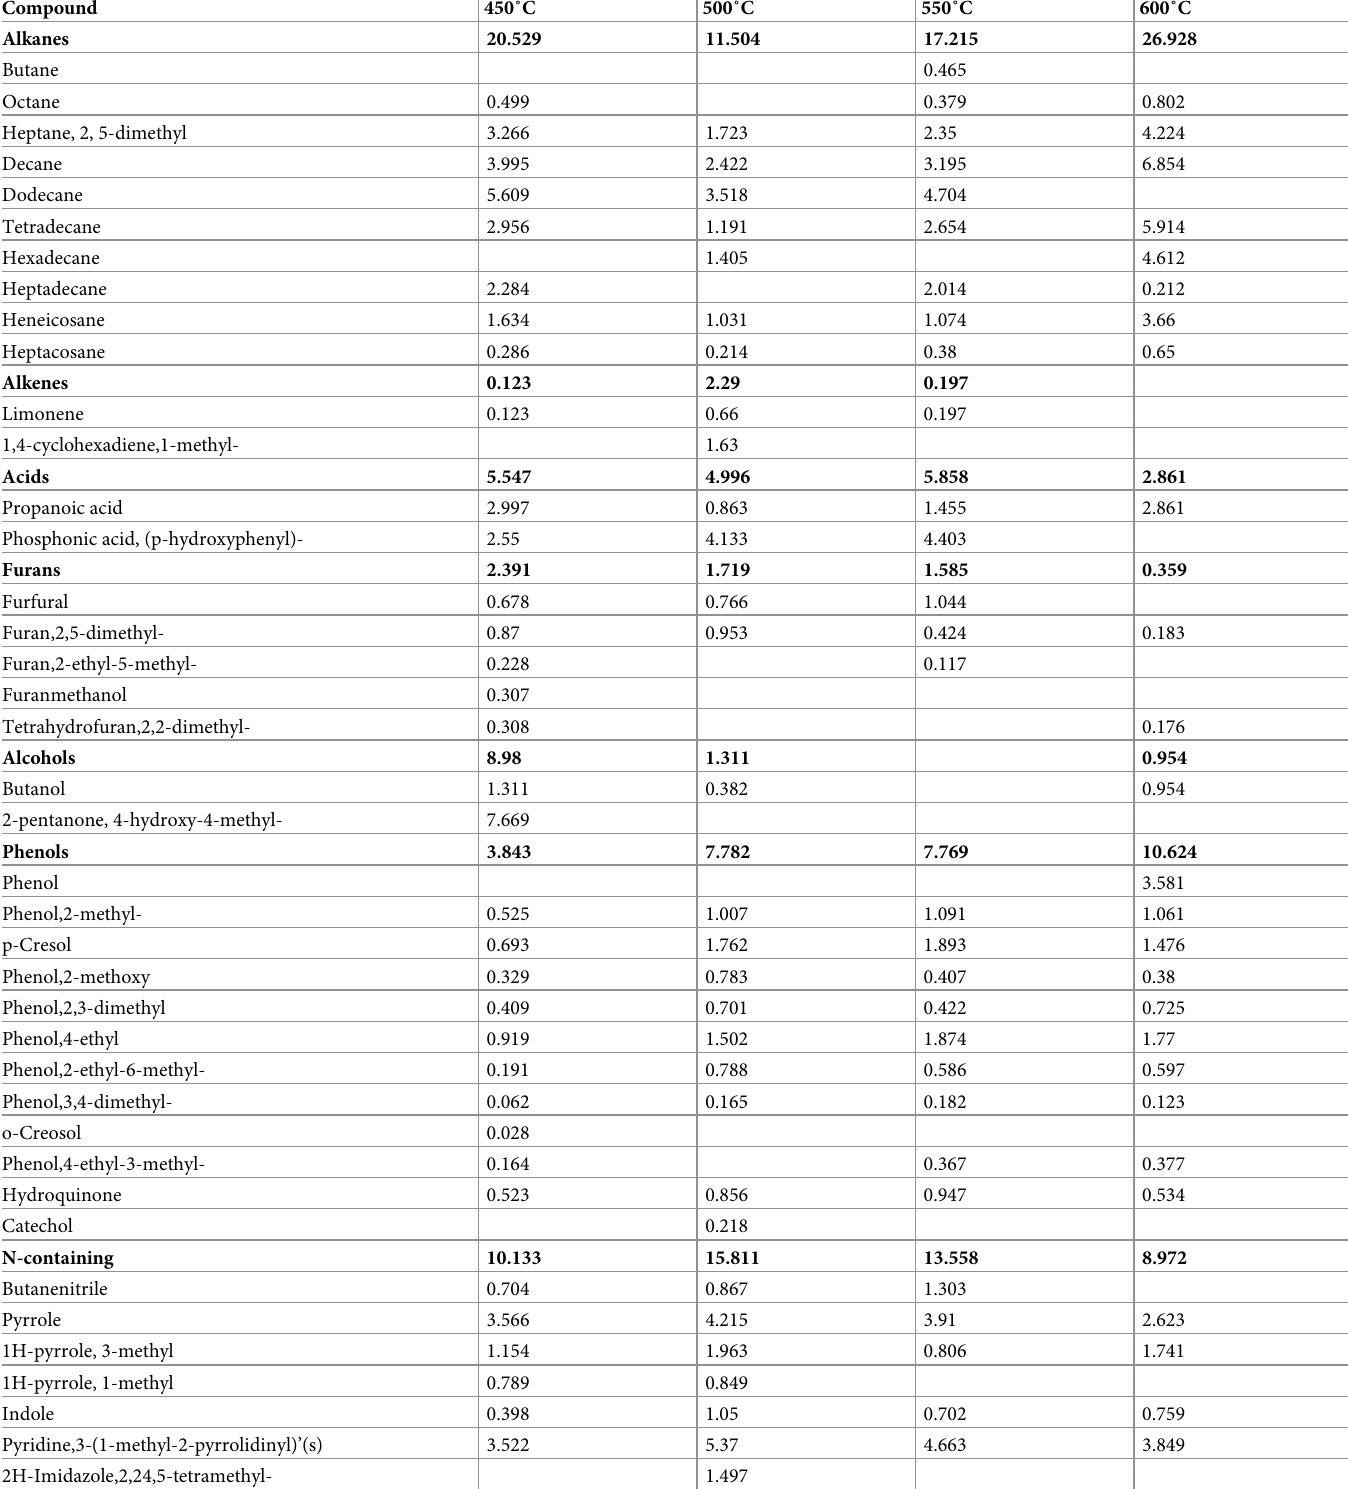
Table 4. Distribution of chemical compounds in pyrolytic bio-oil by GCxGC/TOF-MS area percentage.